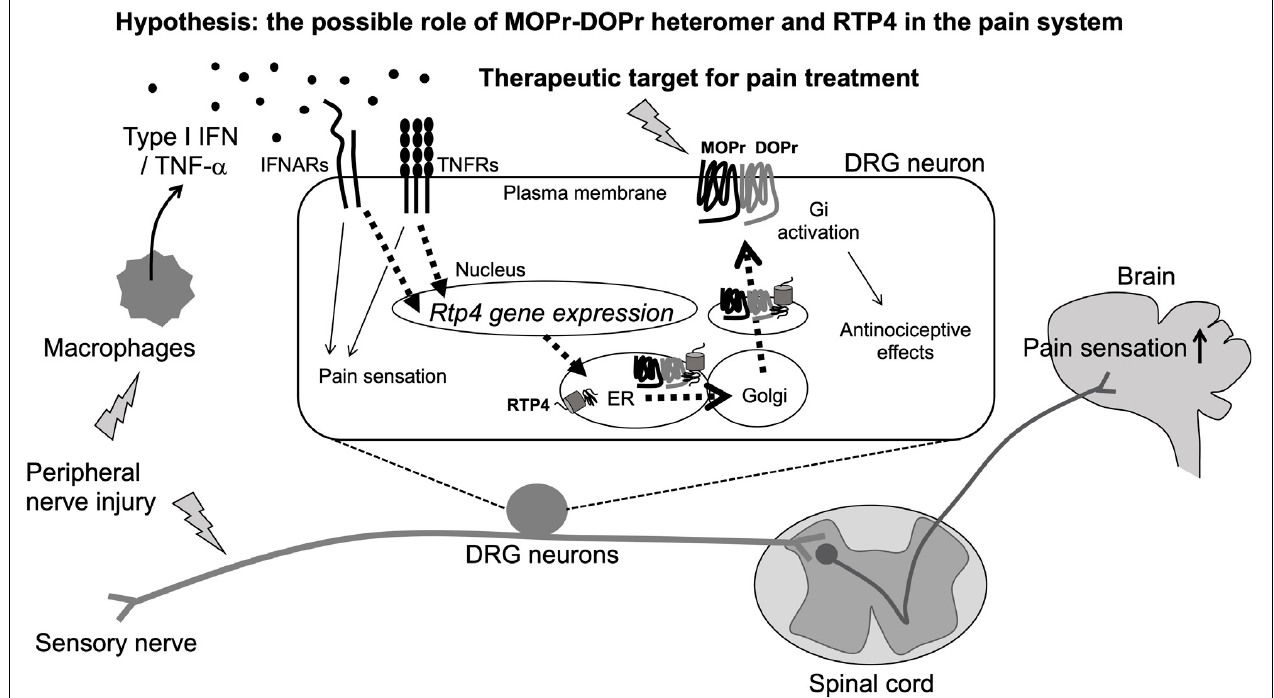
FIGURE 2 | Schematic illustration of pain sensitization and the possible involvement of MOPr-DOPr heteromers and RTP4 in the regulation of pain sensation (Hypothesis). The peripheral nerve injury will stimulate peripheral immune response cells like macrophages that can produce type I IFN. RTP4 could be upregulated following the IFNARs/TNFRs activation in DRG neurons and thus induce the upregulation of MOPr-DOPr heteromer at the cell surface membrane (as a part of compensatory mechanisms occurring during neuropathic pain). Although the critical role for RTP4 and the MOPr-DOPr heteromer in pain sensitization at the spinal cord and the central nervous system is still not clear, the MOPr-DOPr heteromer and RTP4 could be a potent therapeutic target for pain